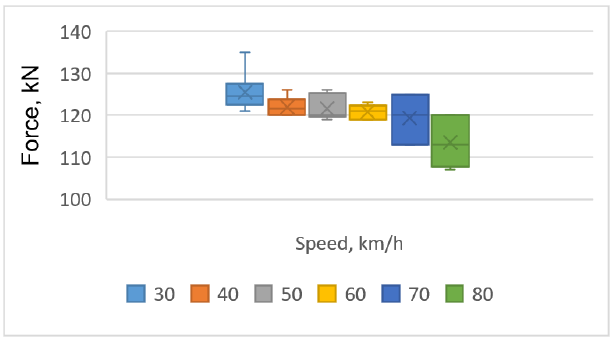
Figure 15. Mean values of vertical force when the wagon is loaded.